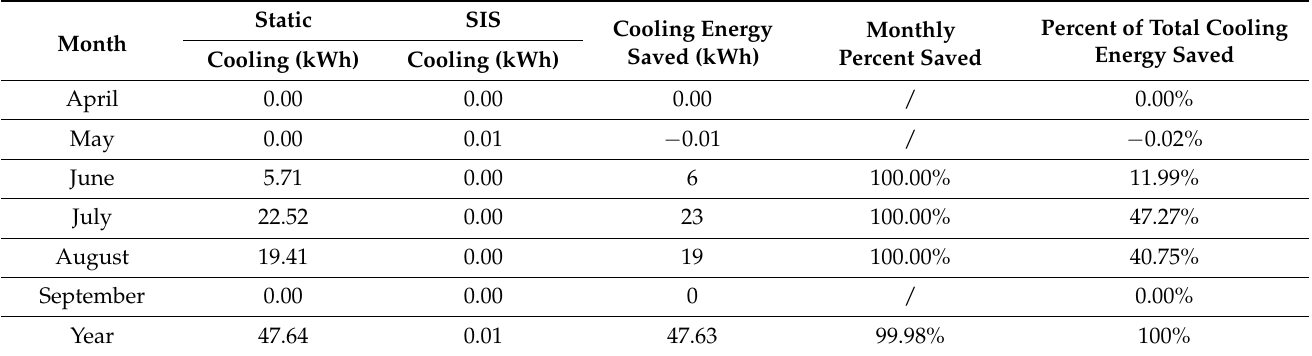
Table 5. Comparison of cooling energy consumption for static and dynamic windows for the prototypical apartment